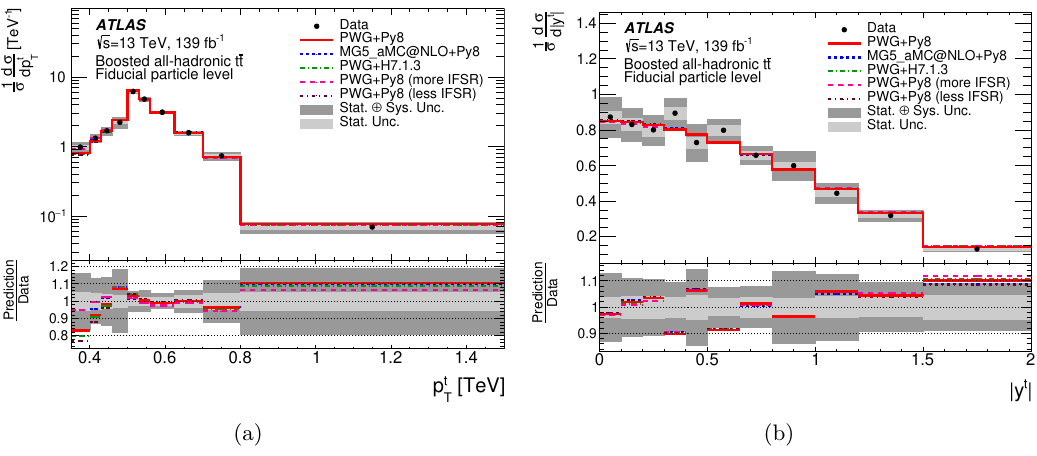
Figure 37 . Normalized particle-level fiducial phase-space differential cross-sections as a function of (a) the transverse momentum and (b) the absolute value of the rapidity of the randomly chosen top-quark jet. The dark and light grey bands indicate the total uncertainty and the statistical uncertainty, respectively, of the data in each bin. Data points are placed at the centre of each bin. The Powheg+Pythia 8 MC sample is used as the nominal prediction to correct the data to particle